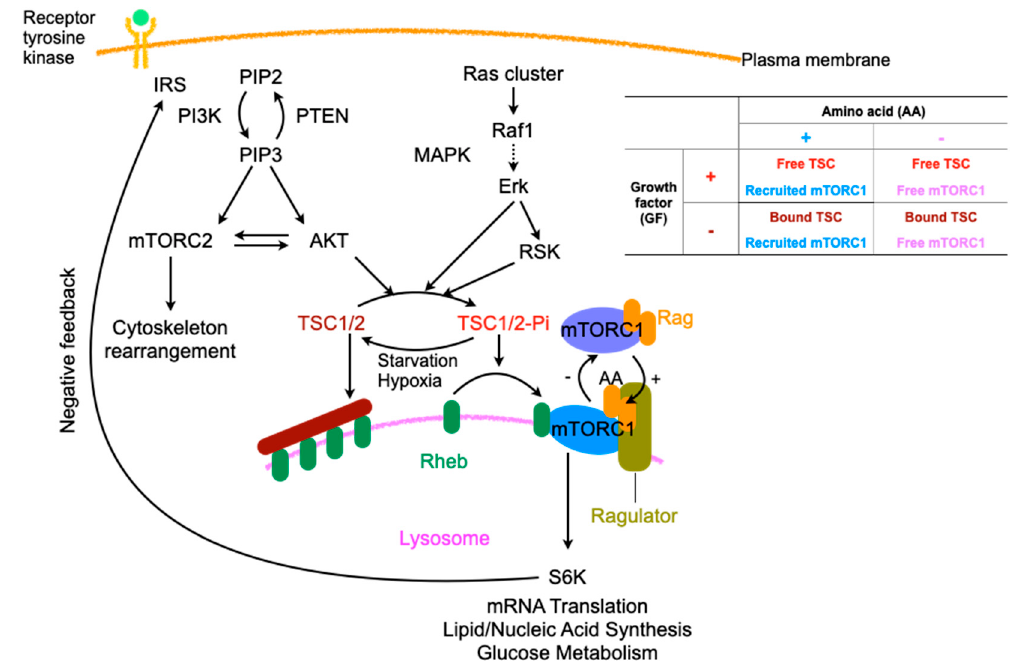
Figure 2. Regulation of mTORC, especially related to amino acids and signals of growth factors. IRS: insulin receptor substrate, PI3K: phosphoinositide 3-kinase, PIP2: phosphatidylinositol-4, 5-bisphosphate, PETN: phosphatase and tensin homolog, mTORC: mTOR complex, MAPK: Mitogen-activated Protein Kinase, RSK: ribosomal protein S6 kinase, TSC: tuberous sclerosis complex, Dotted arrow; abridged signaling factors, In table, + : presence, − : absence. In a nutrient-replete state, an inhibitor of mTORC1 suppresses